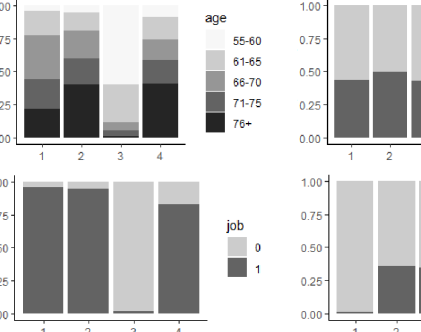
Figure 5. Distribution of descriptive variables by